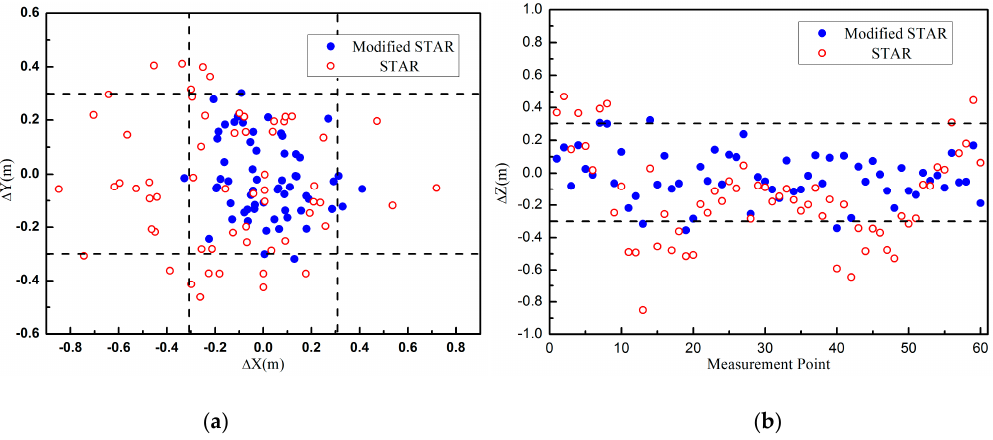
Figure 4. The error distributions of these two methods: ( a ) The error distributions of these two methods on XY plane; ( b ) The error distributions of these two methods in Z-axis.